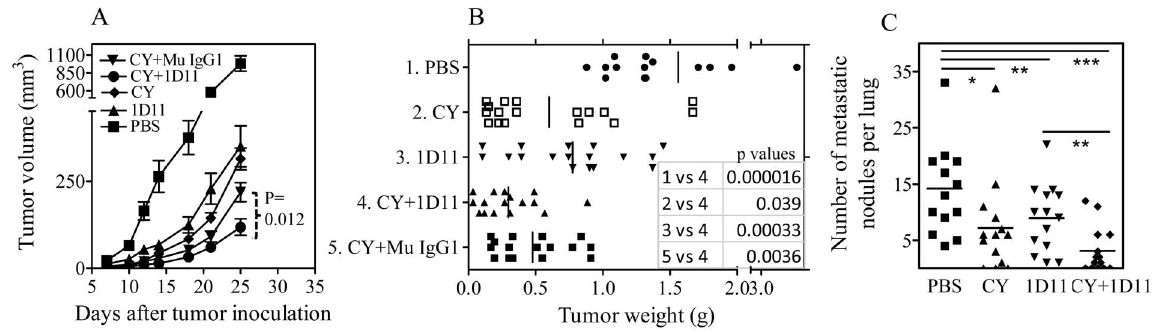
Figure 3. Effect of combination of 1D11and reduced dose of CY on primary tumor growth and pulmonary metastasis. Three days after tumor inoculation, the mice were i.p. treated with single dose of CY (2 mg) or 1D11 (0.1 mg, 3 6 week), or combination of CY and 1D11 or mouse IgG1. Mice were sacrificed , 4 wks after tumor inoculation. (A) Kinetics of tumor growth. The data are representatives of three separate experiments with similar results (N=10, data shown as means 6 SEM). (B) Weight of tumors after 4 wks of inoculation (N=17, pooled from two separate experiments). (C) The number of grossly visible metastatic nodules in the lung (N=14, pooled from two separate experiments). Comparison of indicated groups, * p , 0.05, ** p , 0.01, *** p ,